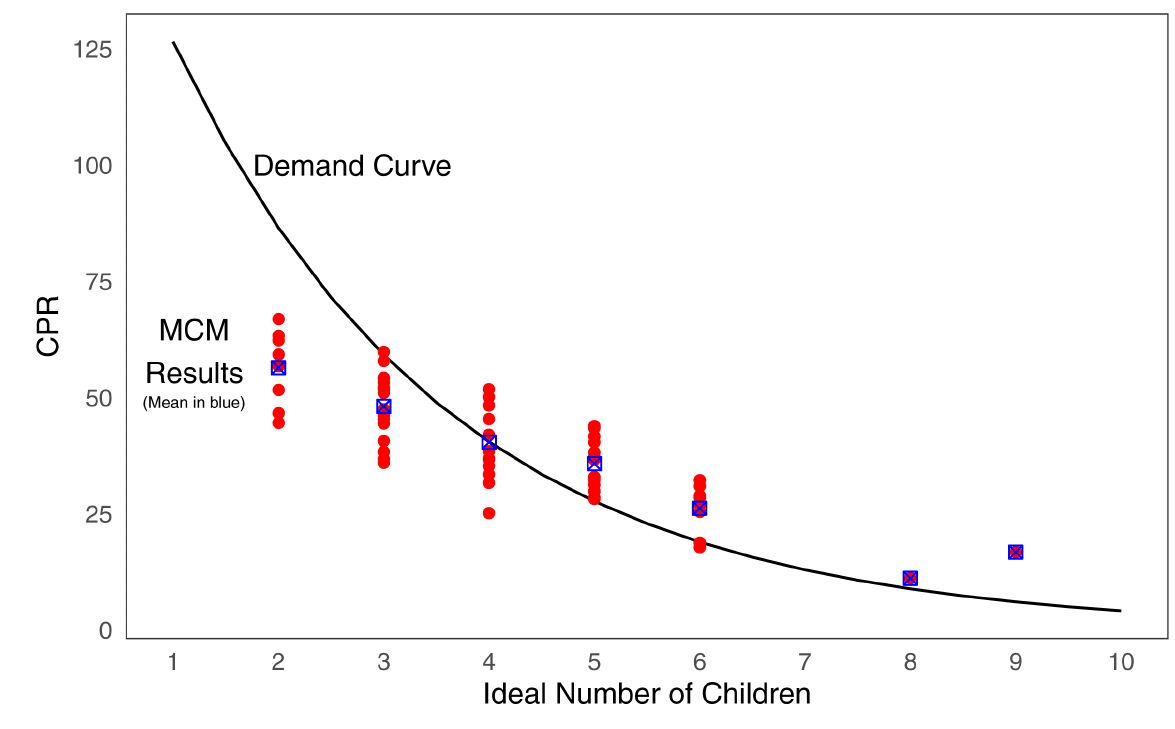
Figure 2. Comparing demand curve with Maximum CPR